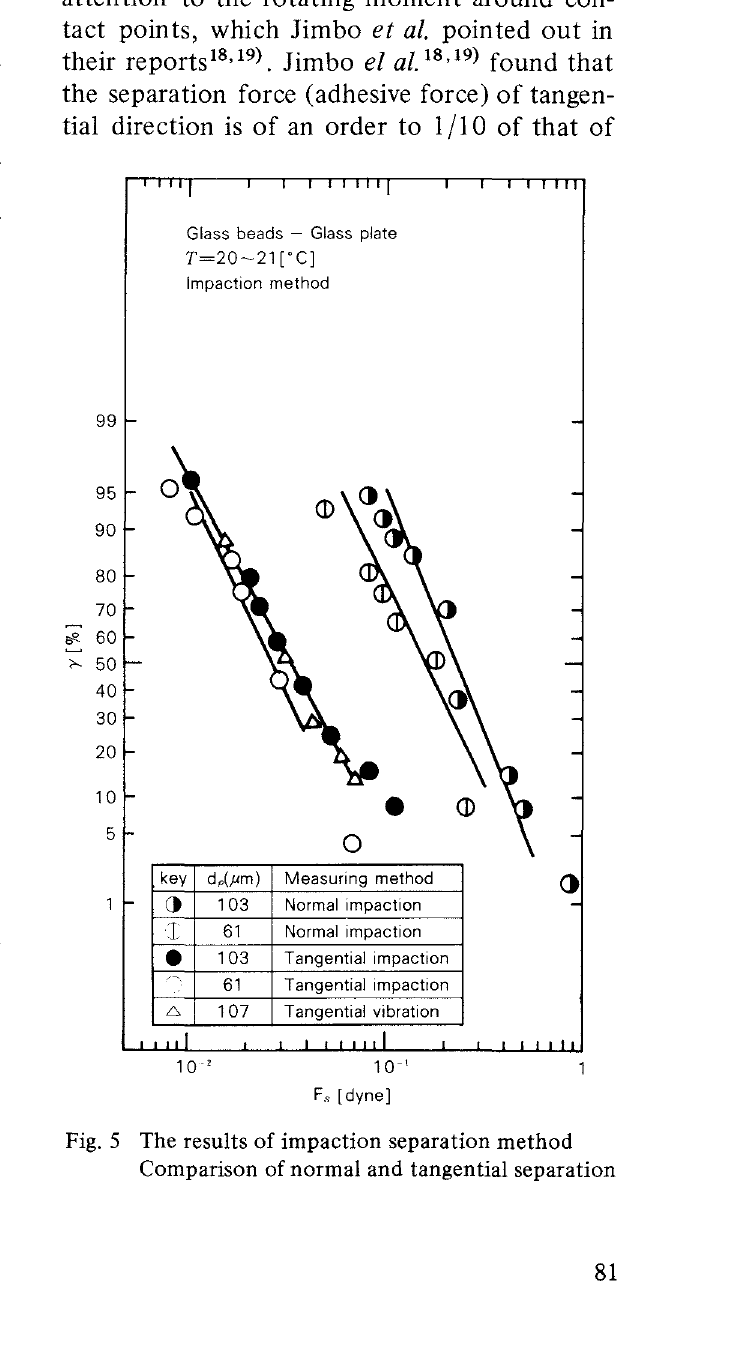
Fig. 5 The results of impaction separation method Comparison of normal and tangential